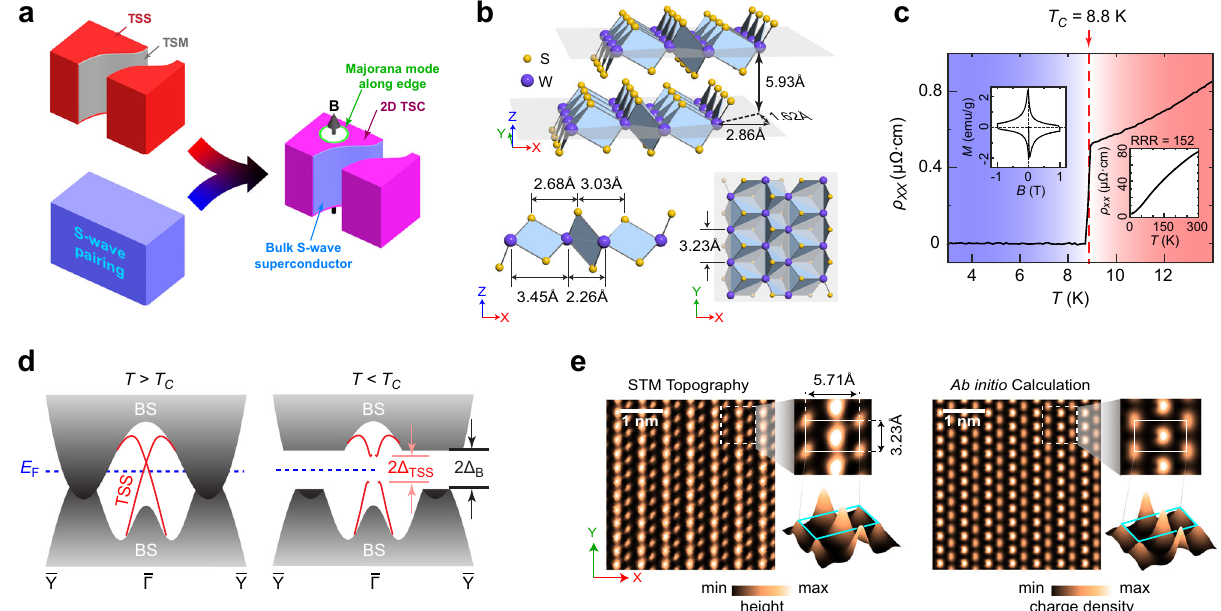
Fig. 1 Introduction to topological superconductivity and general characterizations of 2M-WS 2 . a Illustration on the formation of topological superconductivity in 2M-WS 2 (see text for details). Top panel: Topological surface state (TSS, red color) and the bulk topological semimetal (TSM, gray color) of 2M-WS 2 . Bottom left panel: Bulk s-wave superconductivity at T < T C . Right panel: Surface (2D) topological superconductivity (TSC, magenta color) of TSS, induced by the internal proximity effect from the bulk s-wave superconductivity. Majorana state (green circle) can exist at the magnetic vortex core (illustrated by the black arrow and white color region). b Top panel: 3D view of the crystal structure, showing two adjacent WS 2 layers offset in the X - and Y -directions. Bottom left panel: Side view. Bottom right panel: Top view of a WS 2 layer. c Temperature dependence of resistance shows a sharp superconducting transition at T C = 8.8 K. Left inset: Hysteresis loop of magnetization curve at 2 K showing the Meissner effect and the threshold fi eld value. Right inset: Resistance curve at a large temperature range (3~300 K), showing a residual-resistivity ratio (RRR) of 152. d Illustration of the band structure of 2M-WS 2 in the normal (left) and superconducting states (right). The bulk states (BSs) is shown in solid gray color and the TSSs as solid red lines. In the superconducting states, the BSs and TSSs are both gapped (more details can be found in Fig. 4 below). E F , Fermi energy. Δ TSS and Δ B , superconducting gap of the TSS and the BS, respectively. e Left panel: Surface topography of a cleaved sample from scanning tunneling microscopy (STM) measurement shows the perfect topmost S-atom layer without defects. Zoomed in plots with more information can be found in insets on the right. Right panel: Ab initio calculation of the charge density from the topmost S-atom layer shows excellent agreement with the STM